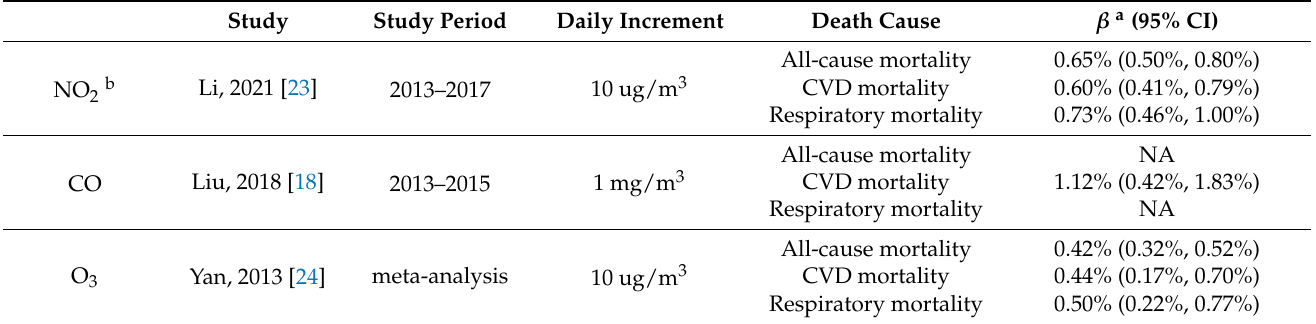
Table 1. The association between daily NO 2 , CO, and O 3 concentrations and mortality obtained from previous studies in